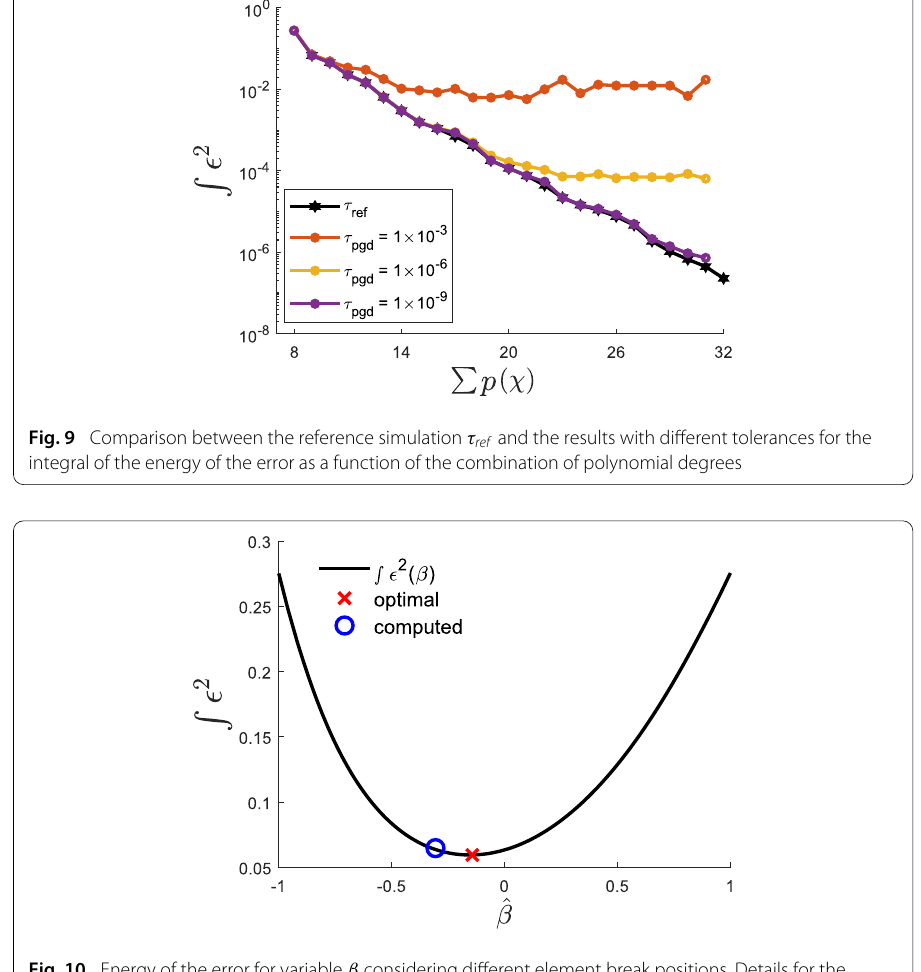
Fig. 10 Energy of the error for variable β considering different element break positions. Details for